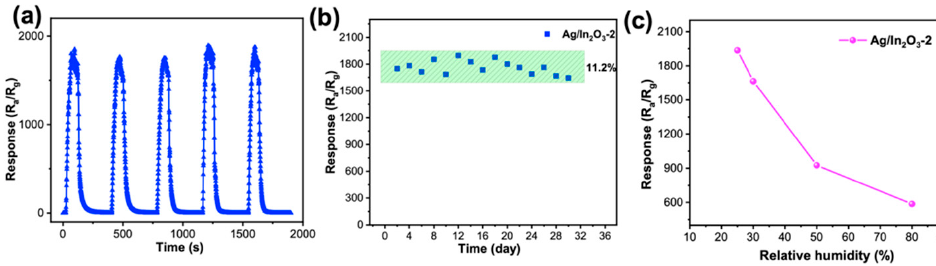
Figure 7. ( a ) Repeatability and ( b ) long-term stability test of Ag/In 2 O 3 -2 for 20 ppm TEA; ( c ) re- sponses of Ag/In 2 O 3 -2 to 20 ppm TEA under different relative humidity (RH).